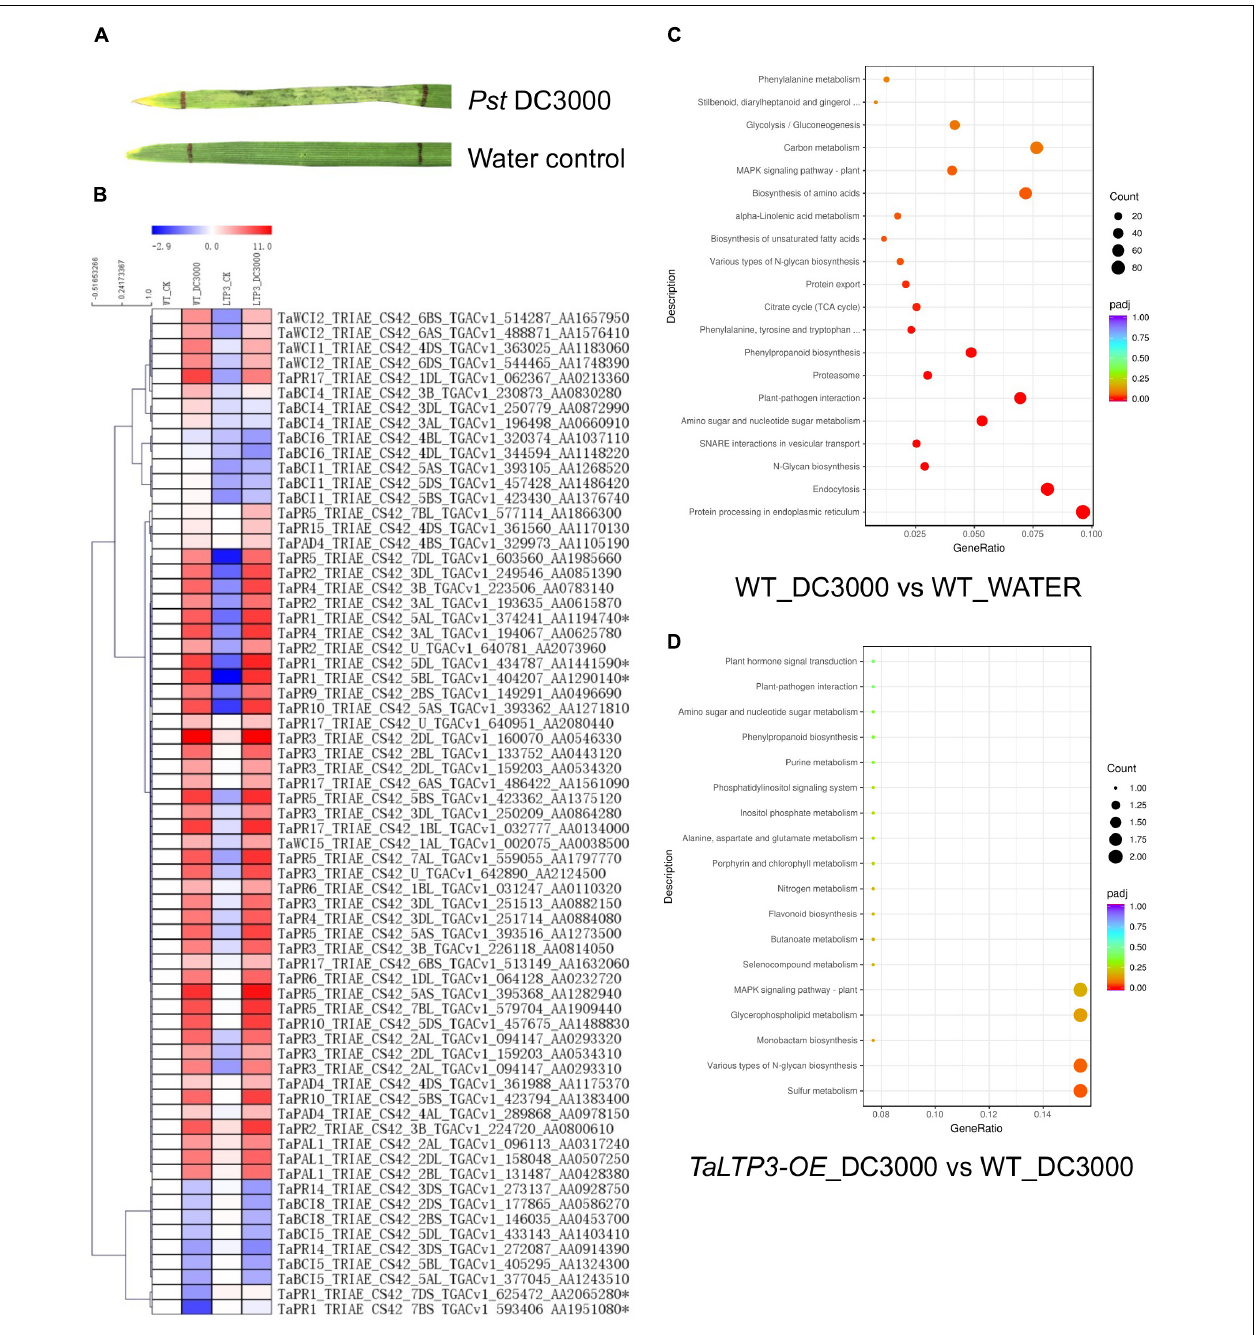
FIGURE 2 | Transcriptome analysis revealed the regulatory network of TaLTP3 during plant defense. (A) A typical cell death was observed in wheat leaf infiltrated with P. syringae DC3000 at 48 h postinfiltration. (B) Expression profile of PR genes upon P. syringae DC3000 infection in TaLTP3-OE transgenic wheat line. FPKM values of WT_DC3000, LTP_CK, and LTP_DC3000 were relative to that of WT_CK. Data were calculated as log2-fold change format by using the Microsoft Excel software. Heatmap was generated by using the MeV software. Genes with similar expression patterns were clustered. (C,D) The Gene Ontology (GO) annotations for upregulated differentially expressed genes (DEGs) in comparisons of “WT_DC3000 vs. WT_WATER”and “ TaLTP3-OE _DC3000 vs. WT_DC3000.” DEGs were classified based on their GO annotations into three main categories including biological process, cellular component, and molecular